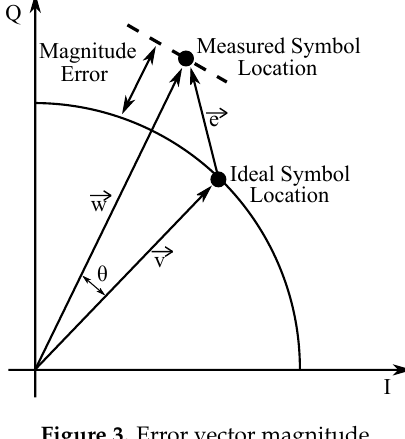
Figure 3. Error vector